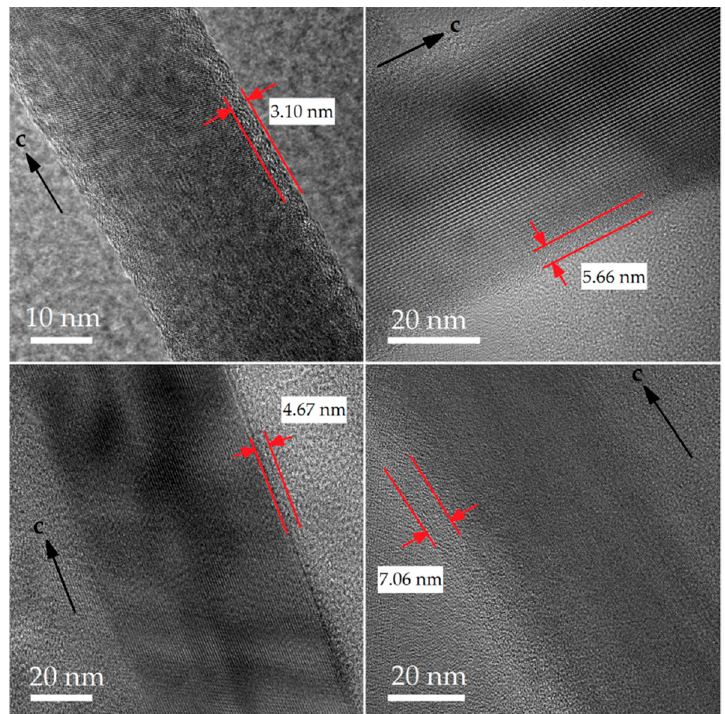
Figure 7. Selected examples (HRTEM images) of four highly crystalline, non-coated crocidolite fibres with a very thin amorphous layer on their surface. Red arrows and red lines highlight the amorphous layer. c = c -axis of crocidolite. The crocidolite fibre shown in the right top box is the same as shown in Figure 5. The images were acquired after a check of the stability of fibre under an electron beam. The black arrow indicates the direction of the crystallographic c-axis.